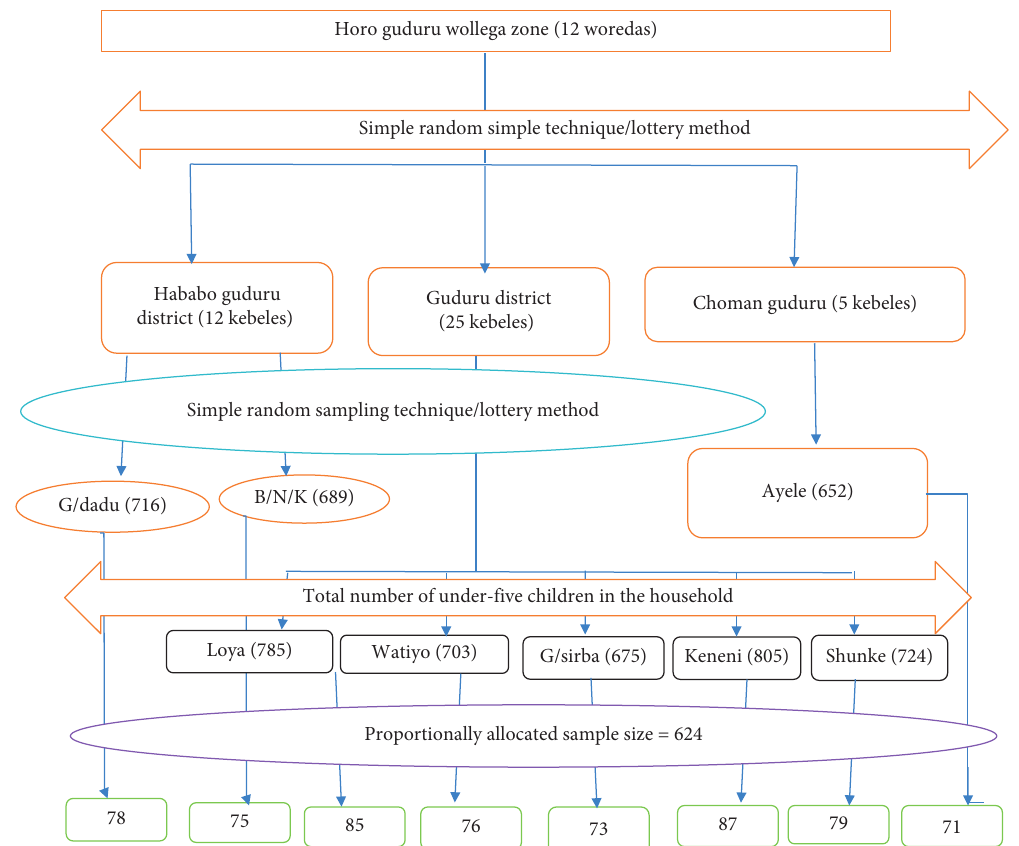
Figure 1: Study participants sampling